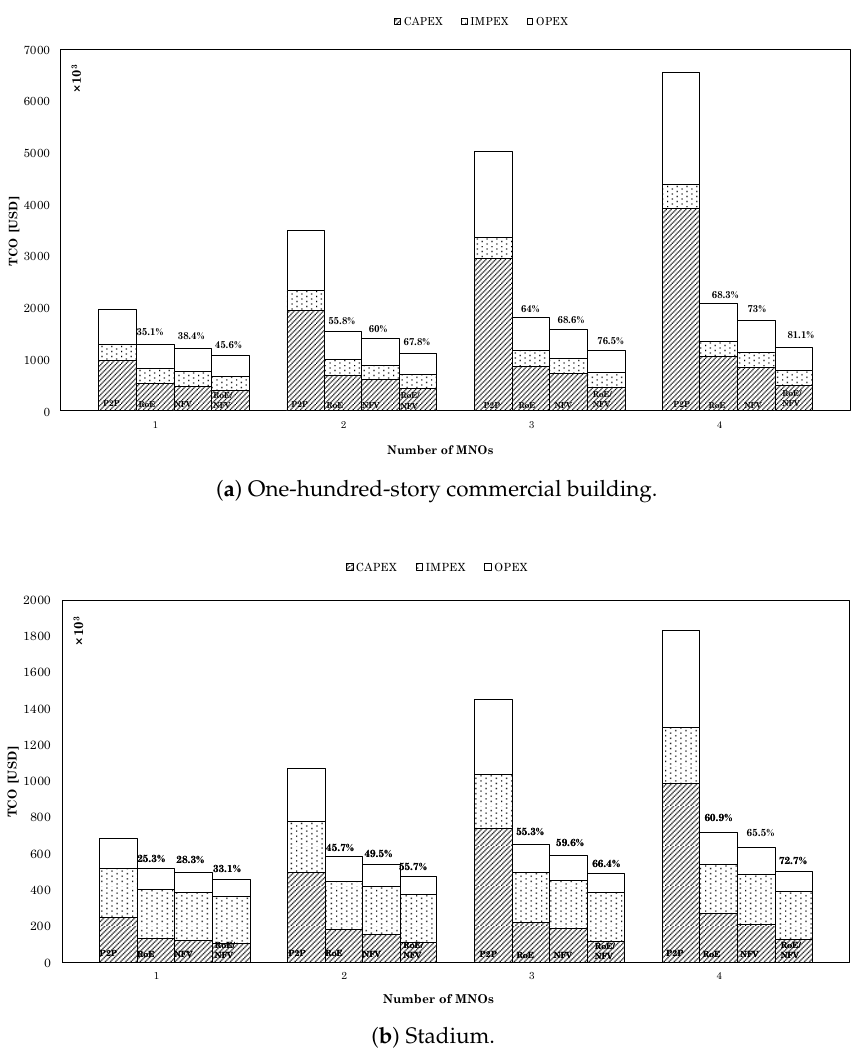
Figure 8. TCO results of the proposed RoE/NFV-based 5GB neutral host design architecture versus P2P, RoE-only, and NFV-only over the deployment